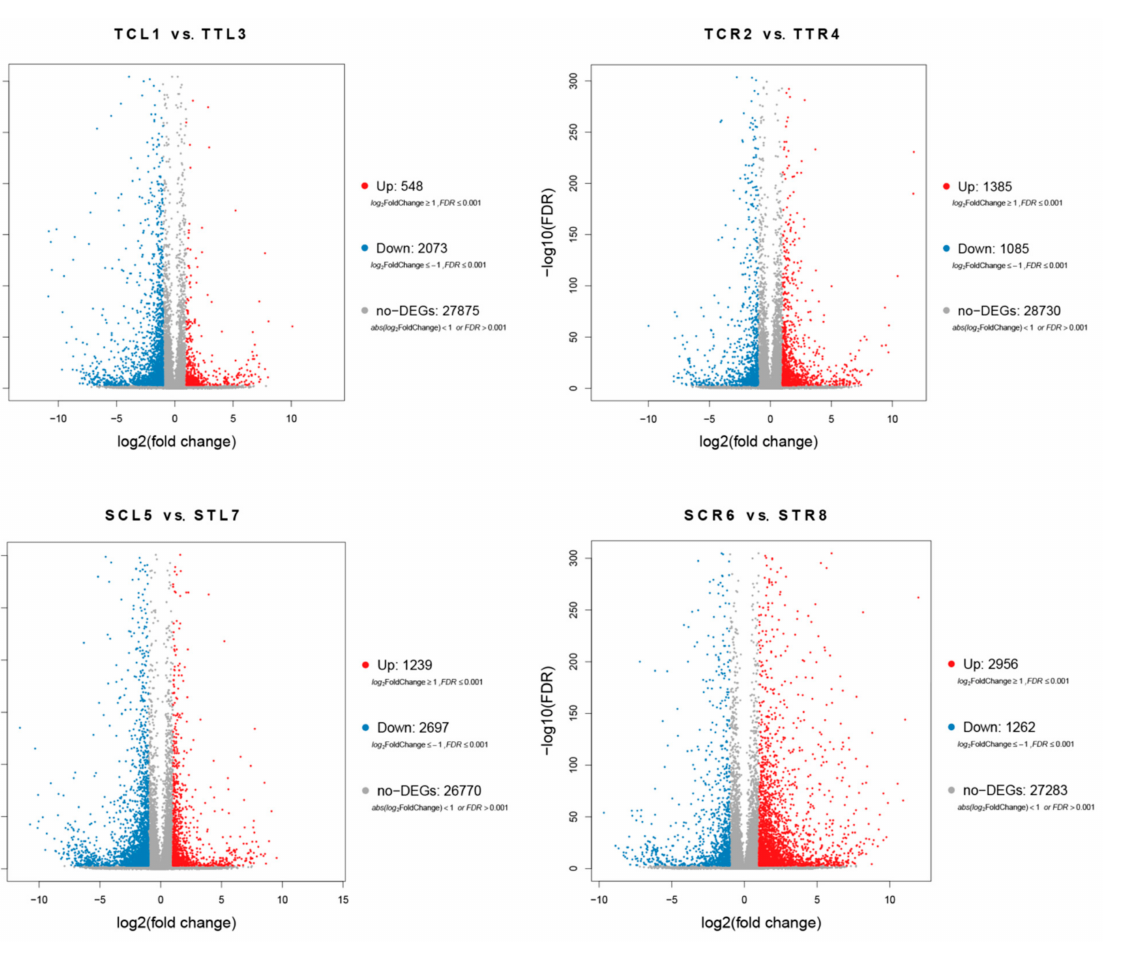
Figure 2. Volcano plot of DEGs. The X-axis represents the value of the difference multiple after log2 conversion, and the Y-axis indicates the significance value after log10 conversation. The three colors red, blue, and gray, represent up-regulated DEGs, down-regulated DEGs, and unchanged genes,